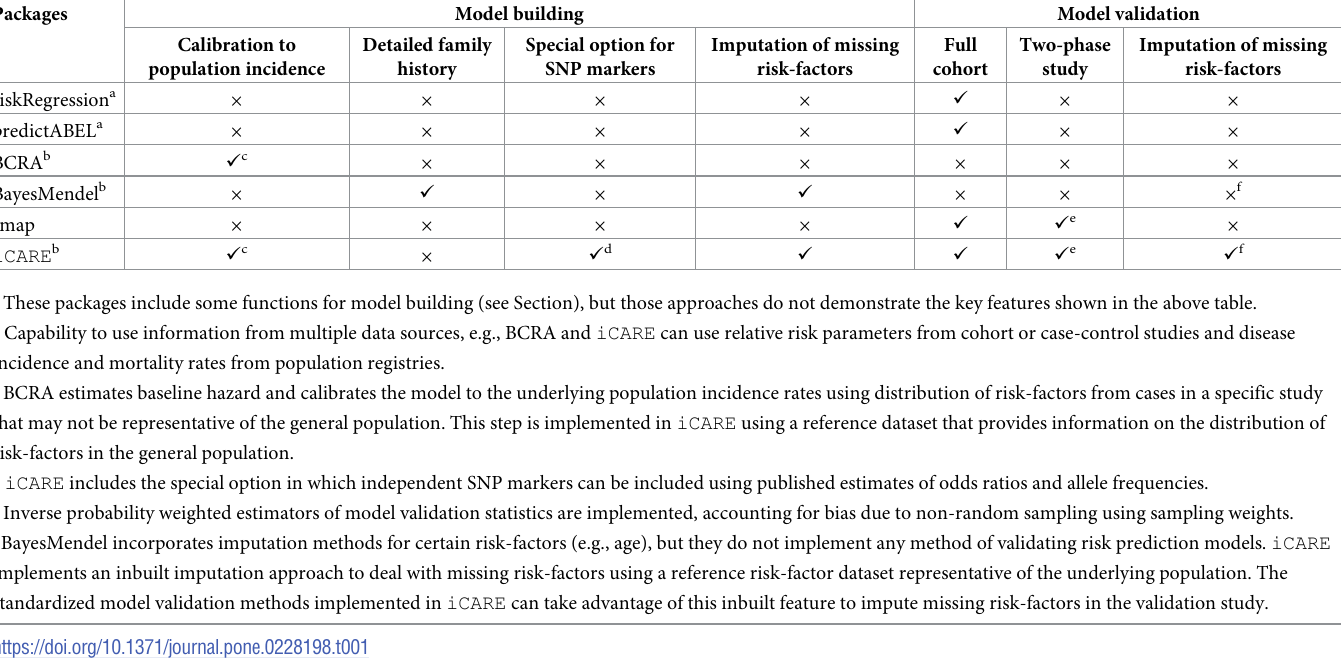
Table 1. Summary of features of existing R packages for risk prediction. ✓ denotes the presence of the feature and × denotes absence of the feature.